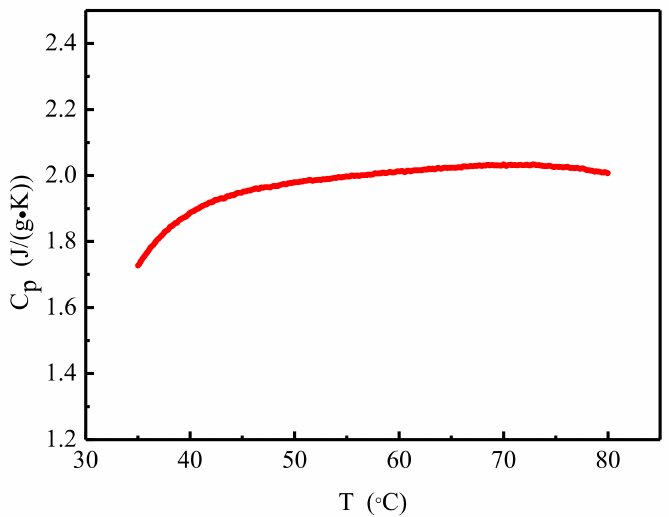
Figure 2. Heat capacity of the solid amine at different